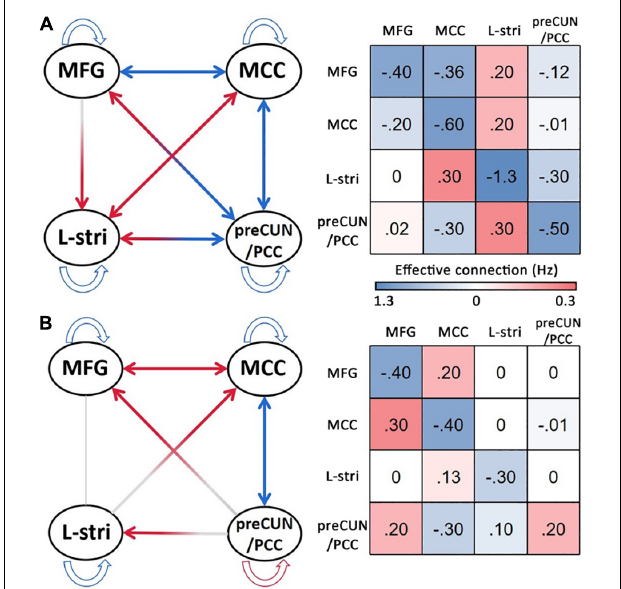
FIGURE 5 | The result of DCM of HC (A) and DoC (B) . L, left; R, right; Stria, striatum; preCUN, precuneus; PCC, posterior cingulate cortex; MCC, middle cingulate cortex; MFG, middle frontal